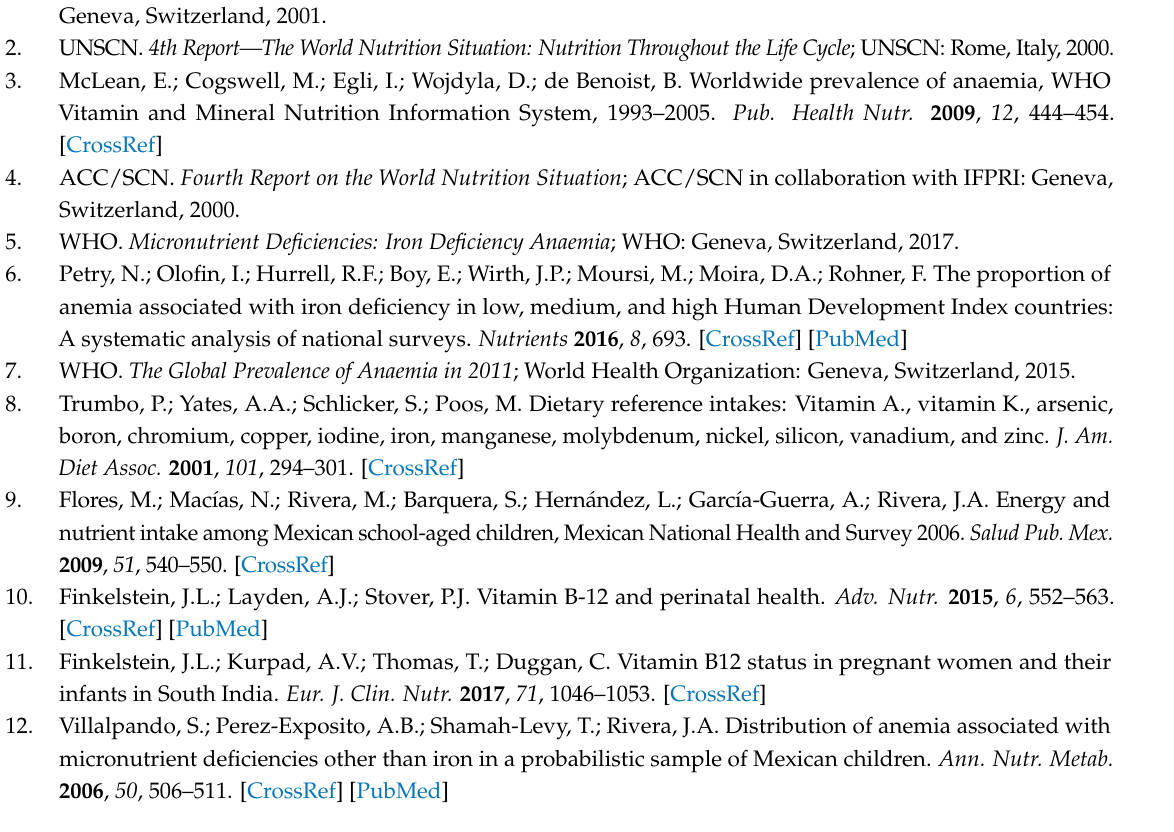
Table S1: Effect of total iron consumed on iron status in children, adjusted for intervention ( n =